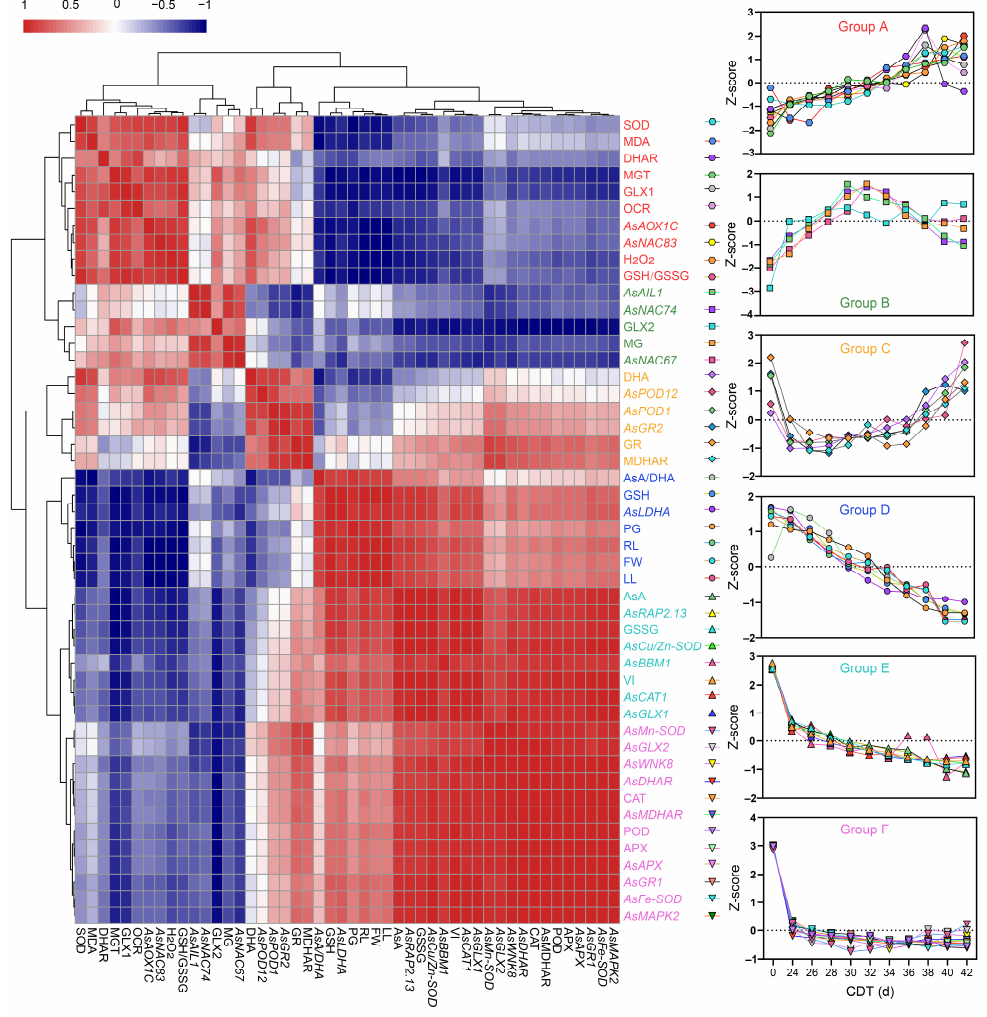
Figure 10. The correlation coefficients between germination indexes, oxygen consumption, ROS and MG content, antioxidants content, antioxidant enzymes activity, glyoxalase activity, and their associated genes transcriptional expression level. According to the correlativity, all 48 indicators were divided into six groups, Group A, Group B, Group C, Group D, Group E, and Group F, which are highlighted with red, green, orange, blue, turquoise, and purple, respectively.